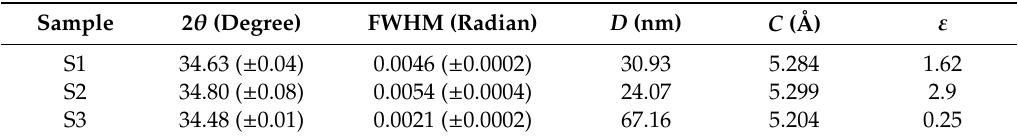
Table 1. Structural parameters of S1, S2, and S3.